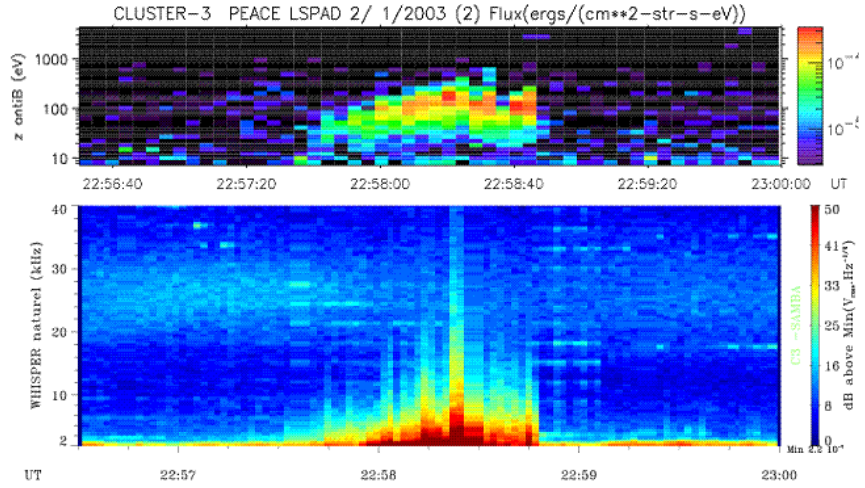
Fig. 8. Energy-time spectrogram of the upgoing electrons detected by PEACE (top panel) and electric field fluctuations observed by WHIS- PER (bottom panel) on 2 January 2003. n b ∼ 1 . 53%, where n b and n p represent the beam and plasma n p